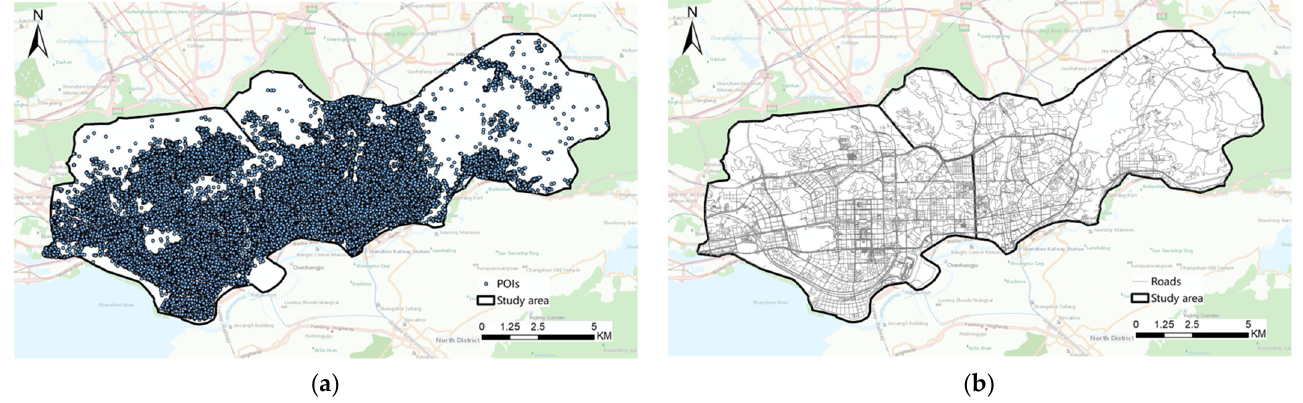
Figure 2. Schematic diagram of data distribution in the study area. ( a ) POIs spatial distribution. ( b ) OSM spatial distribution.